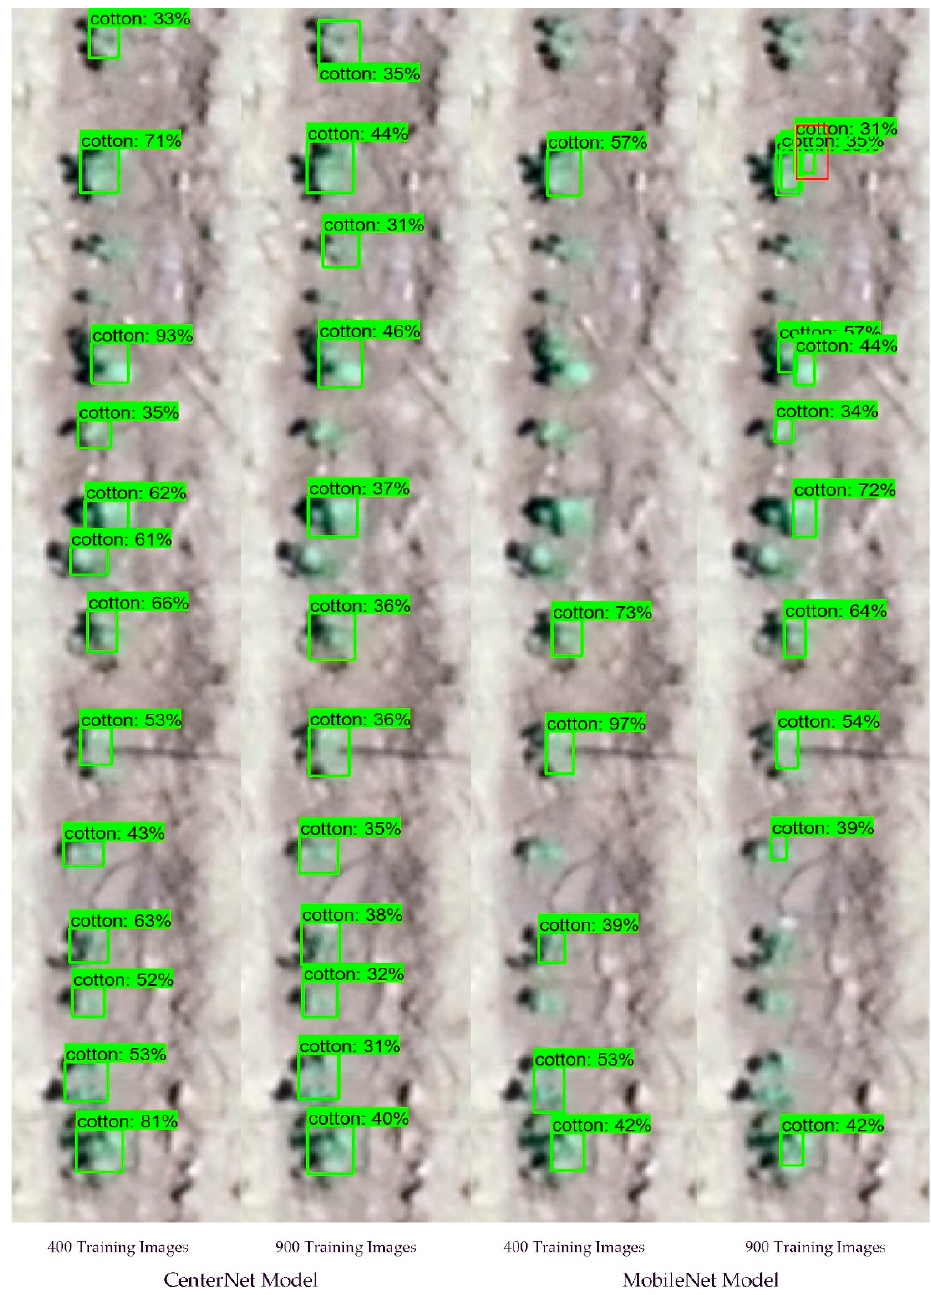
Figure 4. Examples of cotton plant detection and counting results using an unmanned aerial system image acquired on June 14, 2020. Percentage labels around bounding boxes represent F1-scores for detected cotton plants.